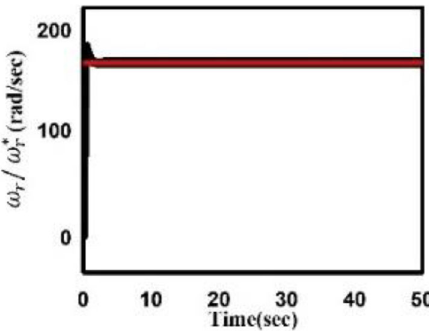
Fig. 14 Adaptive control-based speed tracking